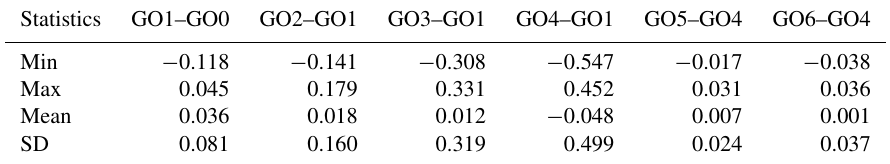
Figure 16. Long-term ZTD trend estimates and their formal errors (error bars) for all processing variants. Table 6. Mean statistics of ZTD trend differences estimated between variants for 172 stations. Units are mmyear − 1 .